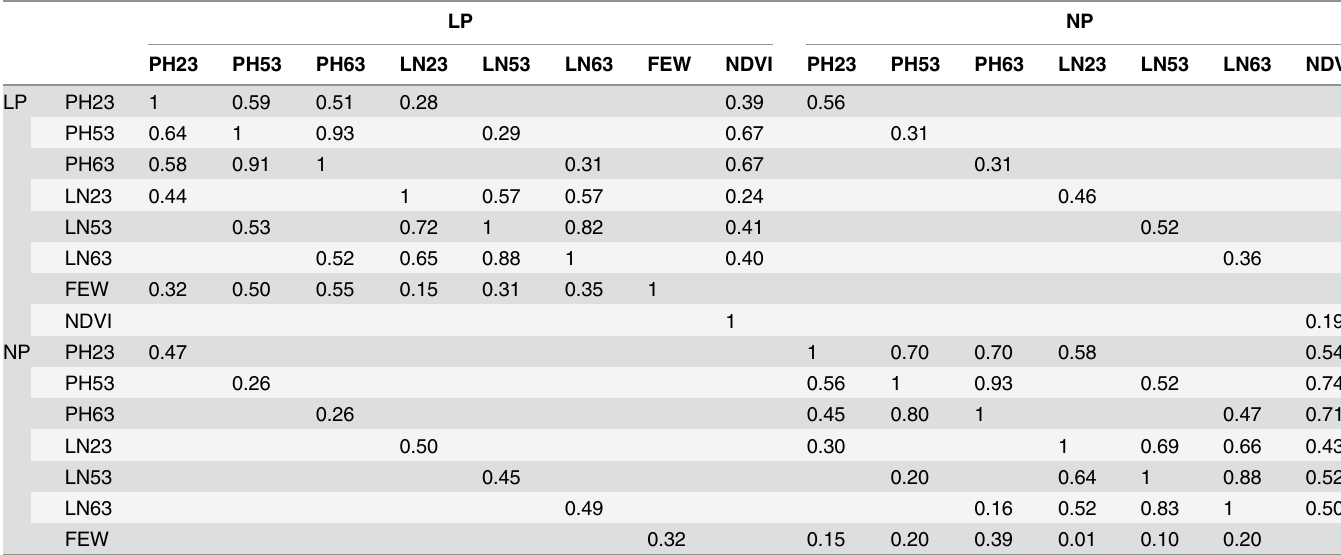
Table 3. Genetic correlations among some tested traits.